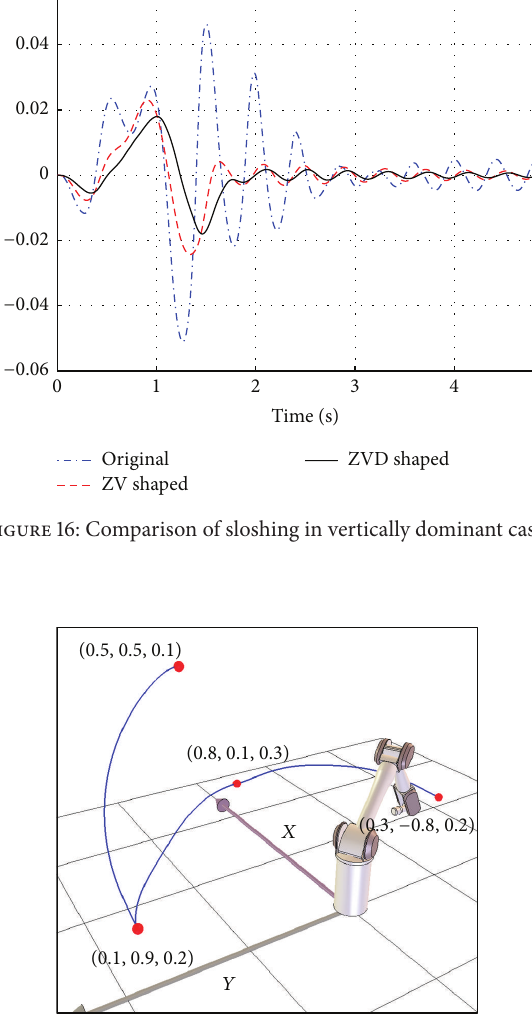
Figure 17: Motion path of the experiment